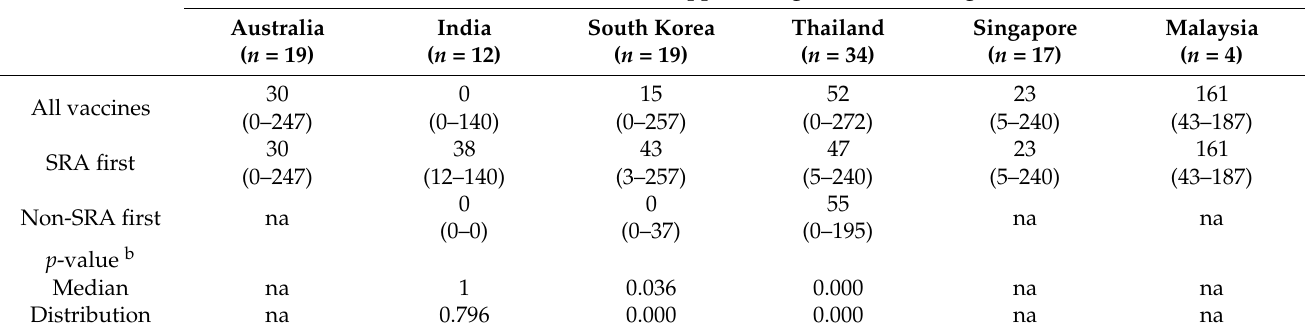
Table 4. Relative approval lag for WHO prequalified vaccines divided by the first approval NRAs. ( n = 61) .